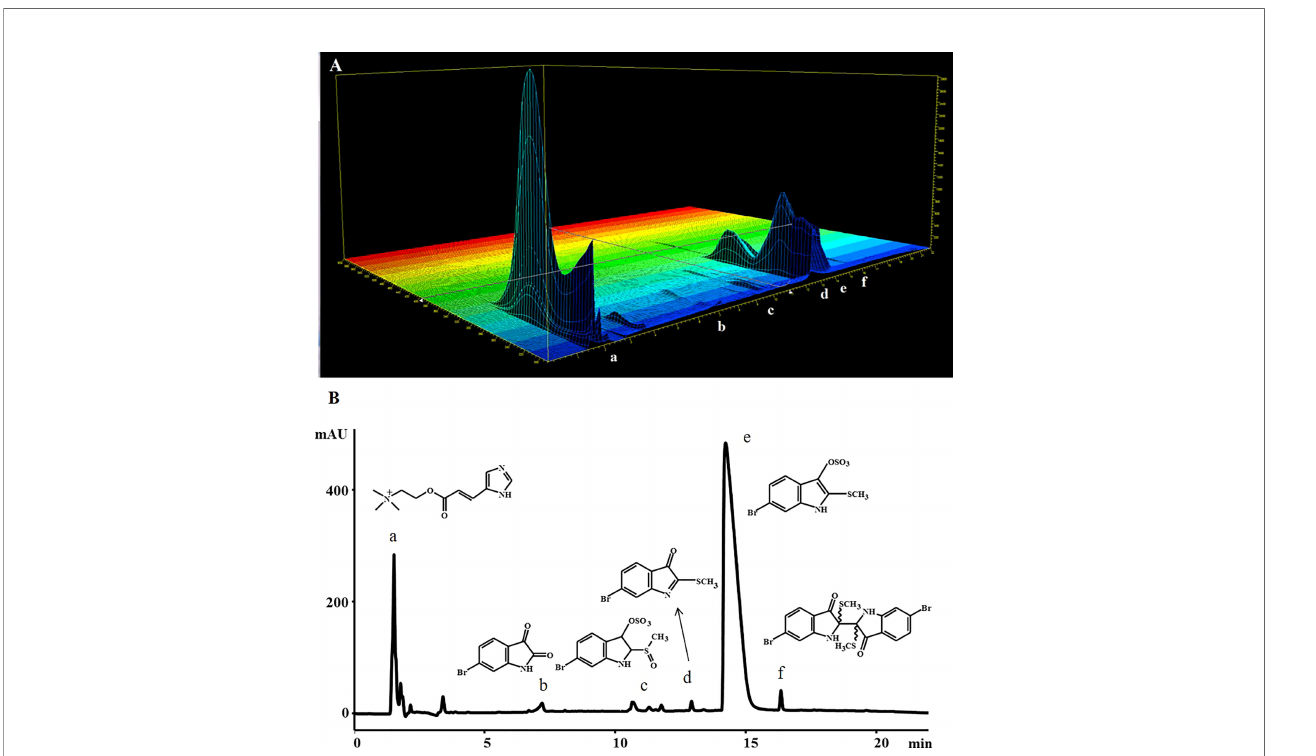
FIGURE 2 | Representative HPLC chromatograms of the secondary metabolites obtained from ethanol extracts from the hypobranchial gland of Dicathais orbita from (A) the diode array of whelks collected from Balliina for the CTMax experiments and (B) 210 nm from whelks collected from Coffs Harbour for the 35 day ocean climate change experiment. Peaks are shown as (a) murexine, (b) 6-bromoisatin, (c) tyrindoxyl S-oxide sulphate, (d) tyrindoxyl sulphate, (e) tyrindoleninone, and (f)